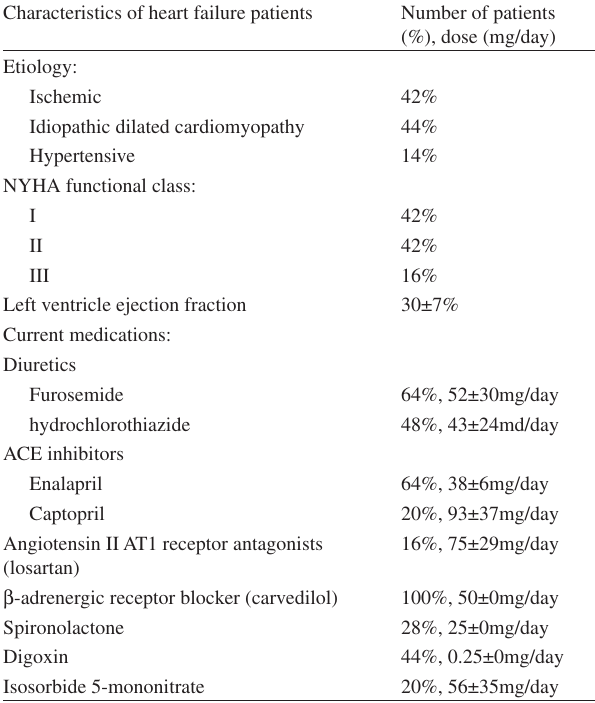
Table 2 - Characteristics of heart failure patients Characteristics of heart failure